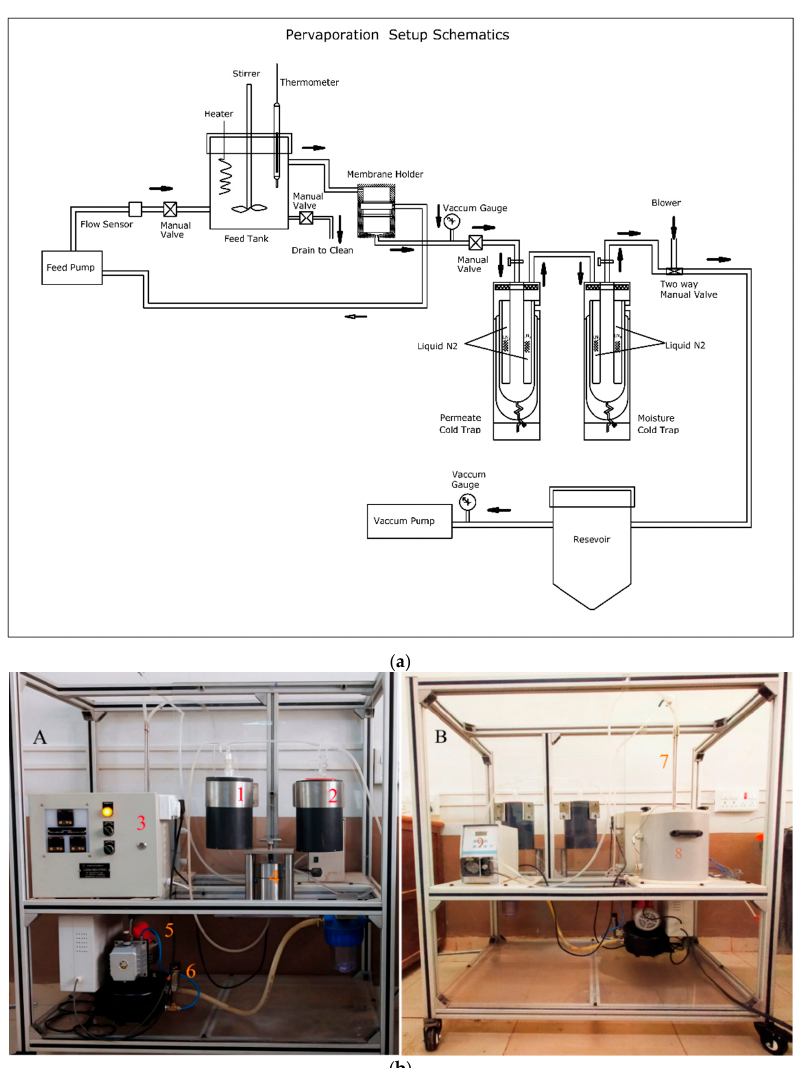
Figure 2. ( a ) Schematic representation of the pervaporation unit. ( b ) Photographic image of the pervaporation apparatus: ( A ) front view: (1) permeate cold trap; (2) moisture cold trap; (3) control panel; (4) pervaporation cell; (5) vacuum pump; (6) vacuum control sensor. ( B ) Back view: (7) inlet and outlet of the feed tank; (8) feed tank; (9) circulation